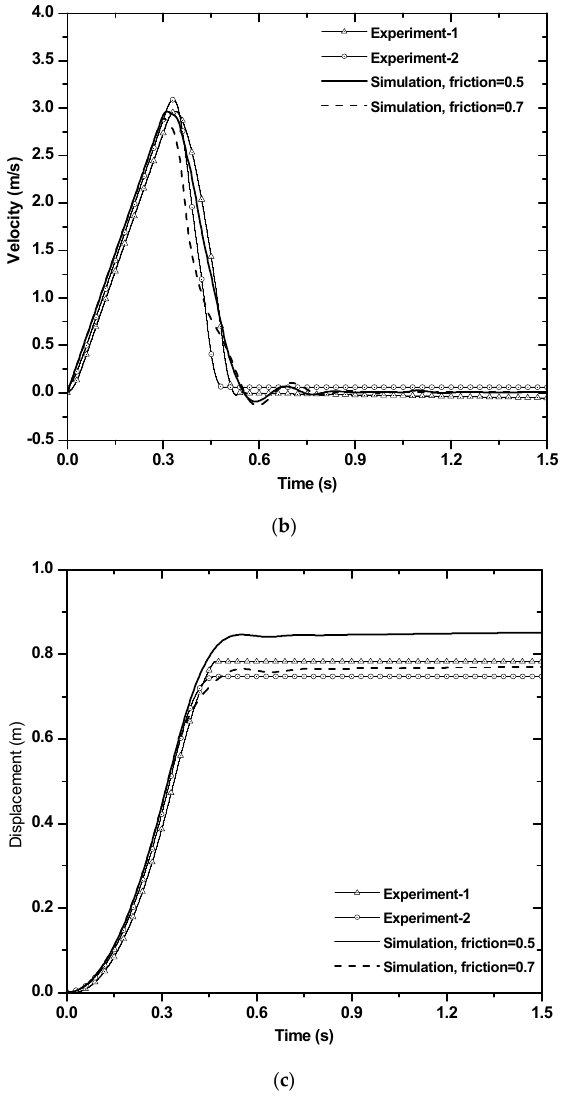
Figure 10. Comparison between the motions of the dropped weight, obtained from tests and simulations (dropped from 0.5 m height): ( a ) acceleration; ( b ) velocity; ( c ) displacement.